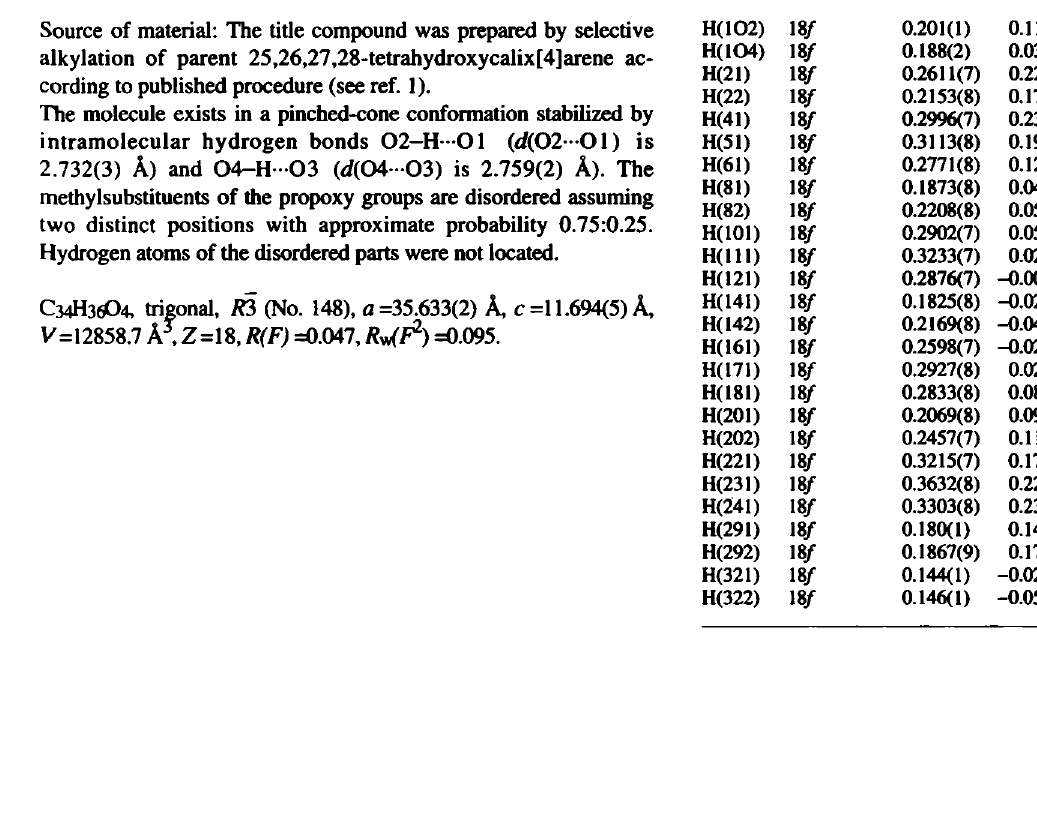
Table 2. Final atomic coordinates and displacement parameters (in A 2